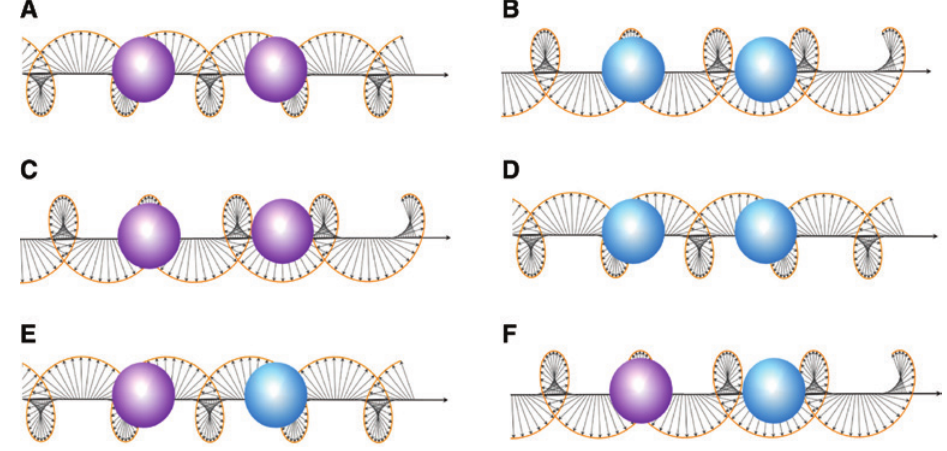
Figure 10: Interplay in differing combinations of optical and material handedness in optically bound pairs of chiral nanoparticles. Illustration of the equivalences (A) ≡ (B) and (C) ≡ (D), and non-equivalences (A), (B) ≠ (C), (D), between the discriminatory optical binding forces for chiral particles of different handedness (depicted by purple and blue spheres) irradiated by circularly polarised light of either handedness (right- and left-handed forms shown with opposite twist). For cases (E), (F), where the two molecules are an enantiomeric pair, the α G discriminatory force